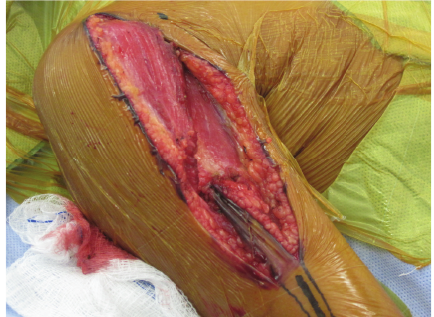
Figure 3: Surgical approach to the proximal humerus.